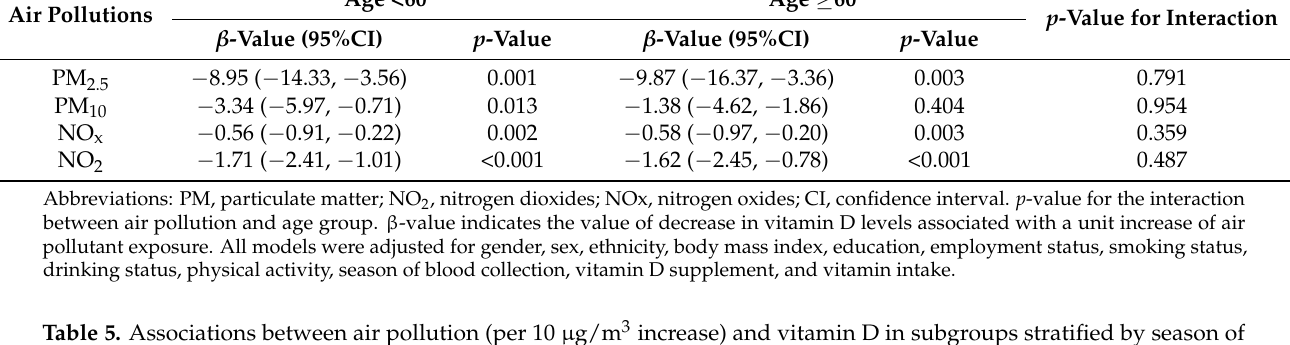
Table 4. Associations between air pollution (per 10 µ g/m 3 increase) and vitamin D in subgroups stratified by age. Air Pollutions